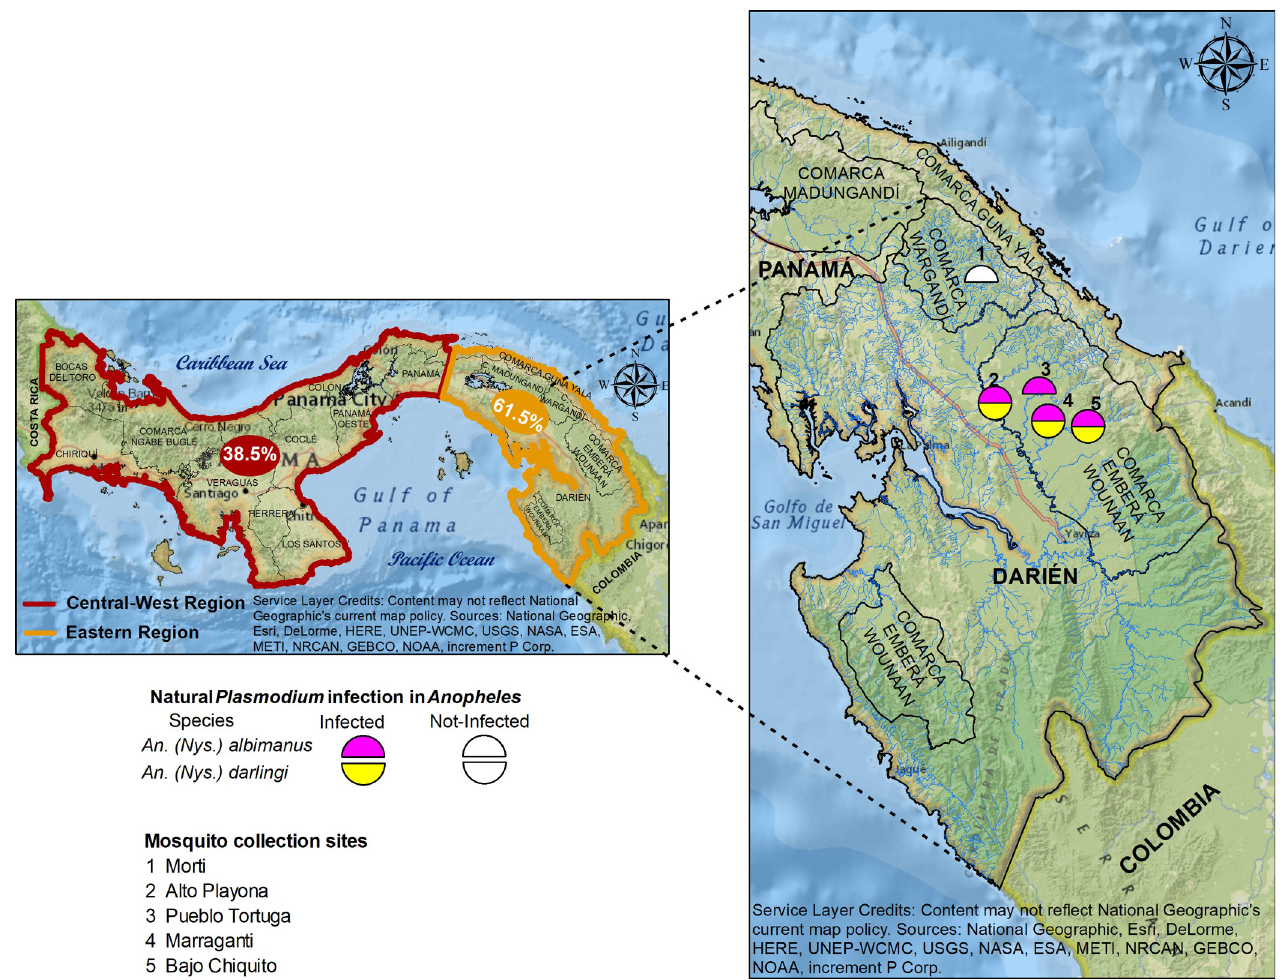
Fig 1. Geographical location of the studied communities in the Darie´n region, Panama. The Map was created using the software ArcGIS Desktop 10.7.1 and ArcGIS Online.